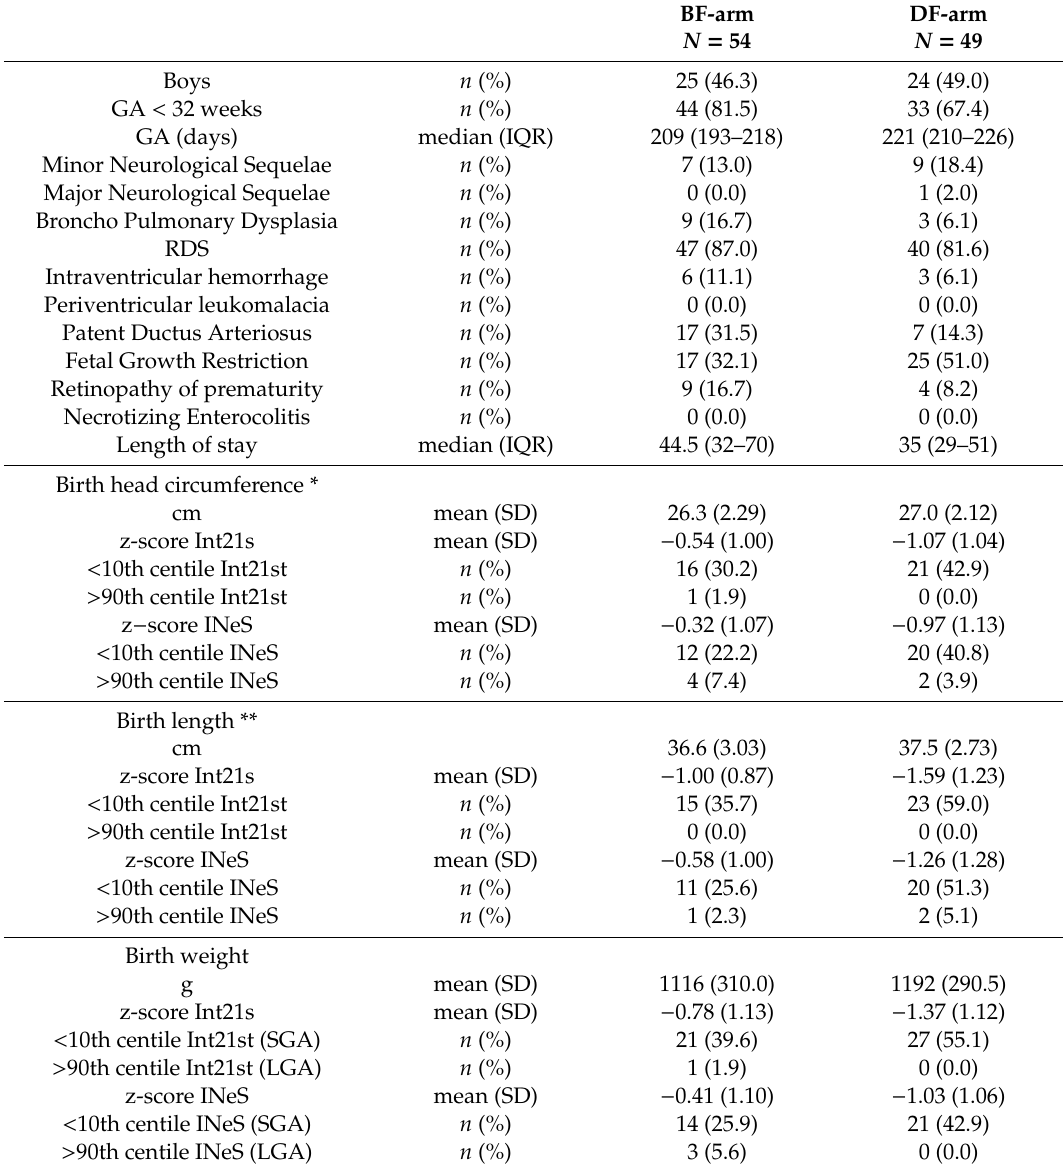
Table 1. Basal characteristics of the 122 children included in the